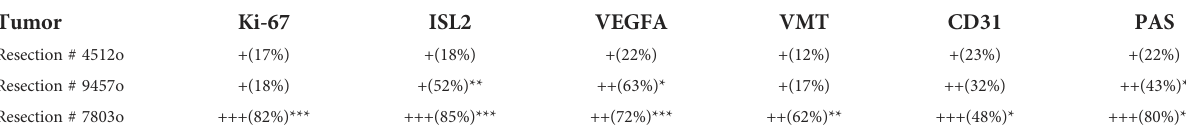
TABLE 1 Immunohistochemical fi ndings.